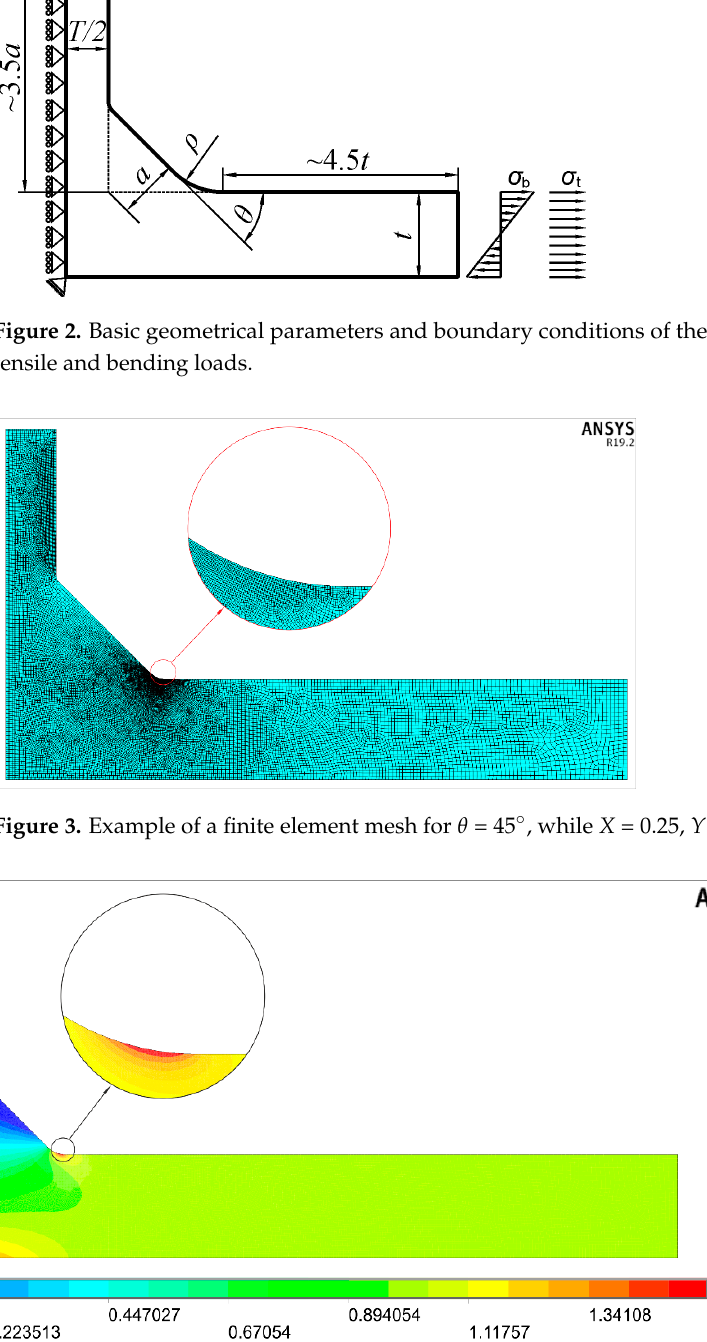
Figure 2. Basic geometrical parameters and boundary conditions of the numerical FEM model for tensile and bending loads.